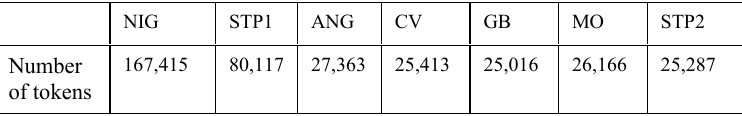
Table 1: Number of tokens of the corpora of Portuguese Varieties NIG STP1 ANG CV GB MO STP2 Number of